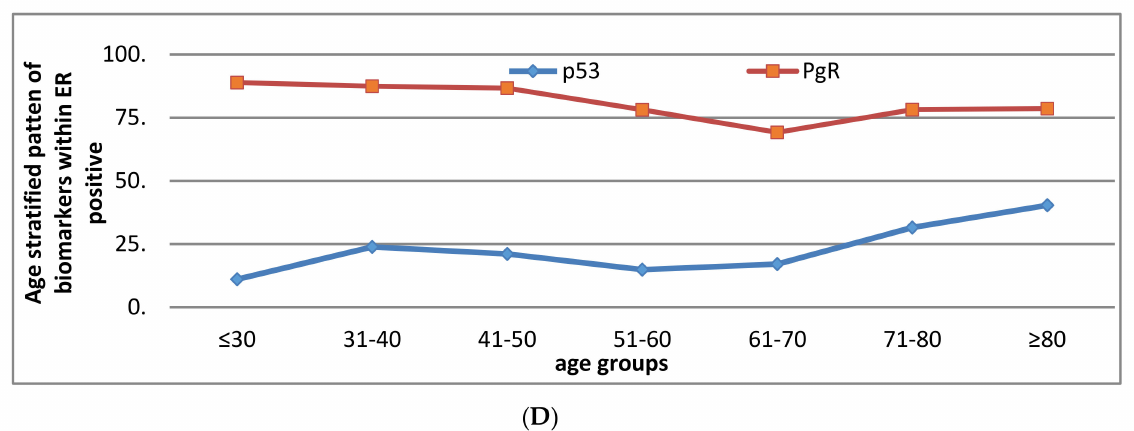
Figure 2. ( A ) Pattern of the expression of biomarkers with age stratification in ER positive early operable primary breast cancer treated by surgery—decline at 40 years. ( B ) Pattern of the expression of biomarkers with age stratification in ER positive early operable primary breast cancer treated by surgery—rise at 70 years. ( C ) Pattern of the expression of biomarkers with age stratification in ER positive early operable primary breast cancer treated by surgery—consistent decline. ( D ) Pattern of the expression of biomarkers with age stratification in ER positive early operable primary breast cancer treated by surgery—two peaks.